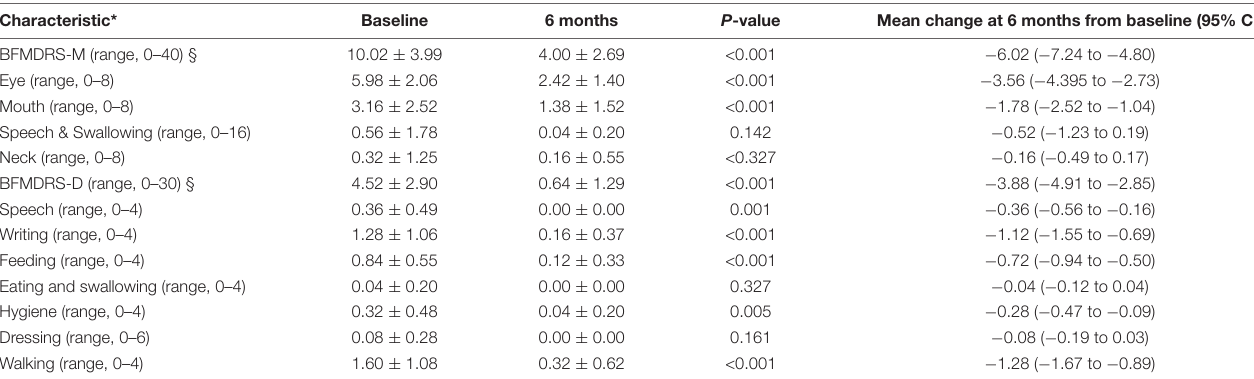
TABLE 2 | Burke–Fahn–Marsden dystonia rating scale scores at baseline and 6 months postoperatively. Characteristic*